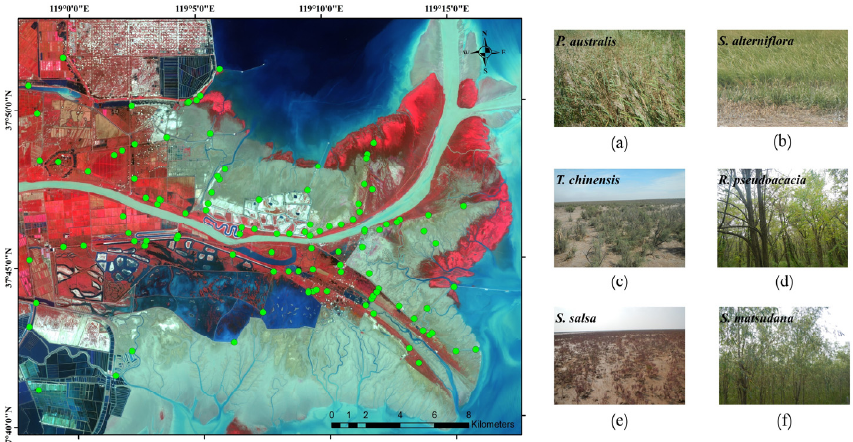
Figure 2. The distribution of field survey points overlaid on the Sentinel-2 MSI false-color images (R: 8, G: 4, B: 3). The image to the right is the photo of different vegetation types, including ( a ) P. australis , ( b ) S. alterniflora , ( c ) T. chinensis , ( d ) R. pseudoacacia , ( e ) S. salsa , ( f ) S. matsudana .